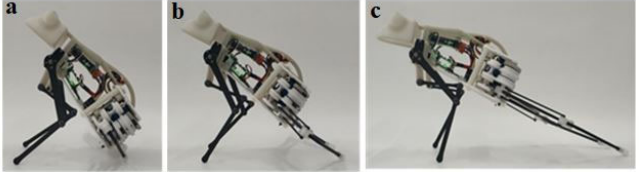
Figure 14. The movements of the hindlimb jumping: ( a ): Complete contraction of hindlimb; ( b ): Semi ‐ extension of hindlimb; ( c ) Fully extension of hindlimb.